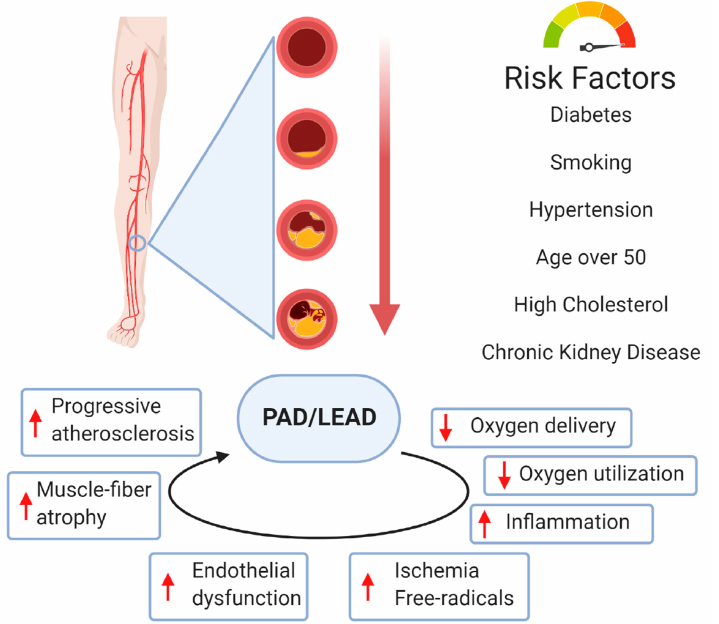
Figure 1. The main risk factors for the progression of peripheral artery disease (PAD)/lower extremity artery disease (LEAD) and mechanisms of pathophysiological impairment associated with PAD. Created with BioRender.